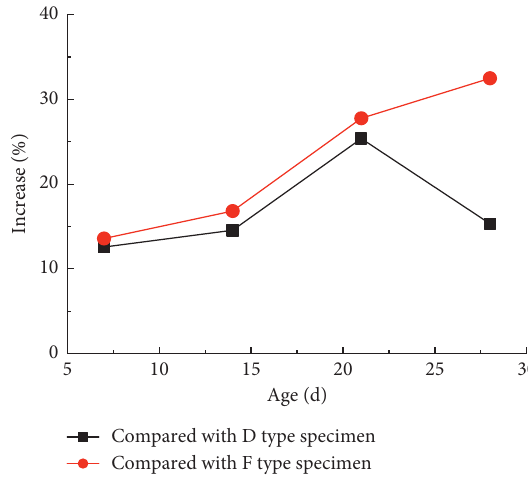
Figure 14: Increasing curve of axial strain.